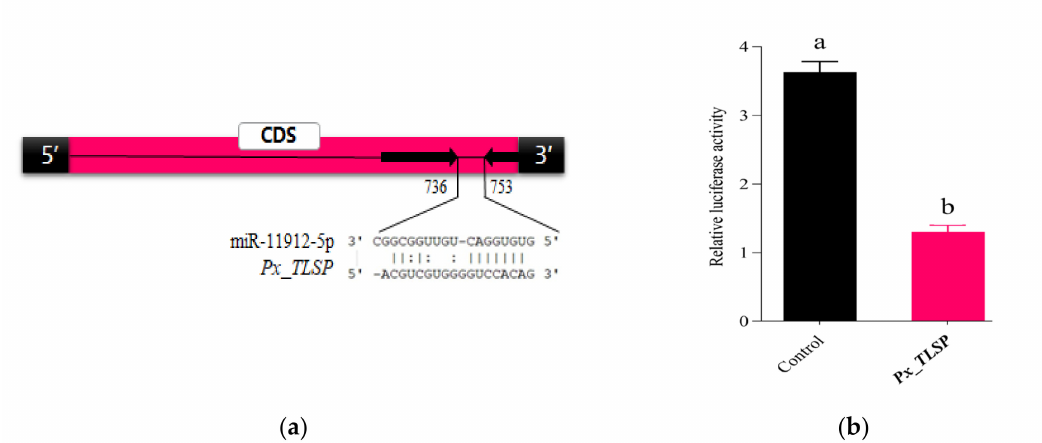
Figure 4. Prediction and validation of miR-11912-5p and its target site in vitro. ( a ) Predicted target site of miR-11912-5p in Px_TLSP by TargetScan, RNAhybrid and miRanda; ( b ) validation of miR-11912-5p- Px_TLSP direct sequence interaction by dual luciferase assays using HEK293T cells 48 h after co-transfection with the psi-CHECK2 construct presented as Mean ± SEM of three biological replicates. Letters indicate significant differences p < 0.01.